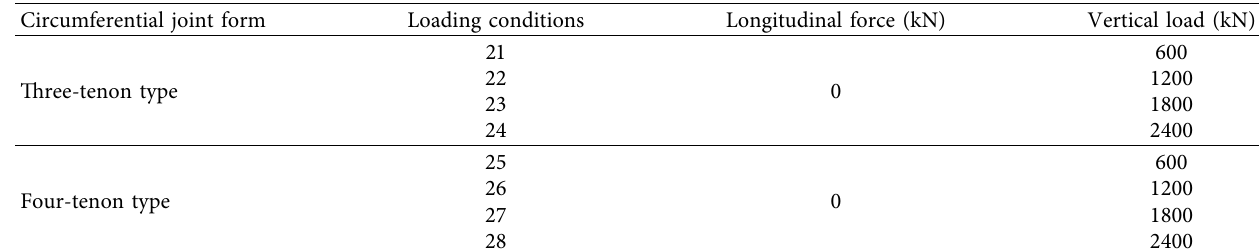
Figure 7: Steel bar of B3 segment. Table 2: Loading cases of single